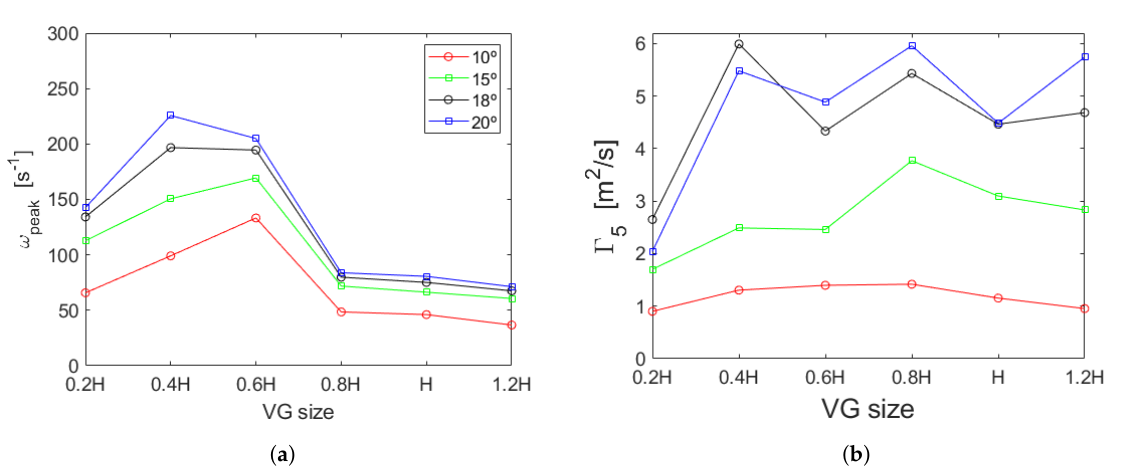
Figure 9. Peak vorticity and circulation for different VG sizes at a 5 δ distance from the VGs trailing edge. ( a ) Streamwise peak vorticity; ( b ) ositive